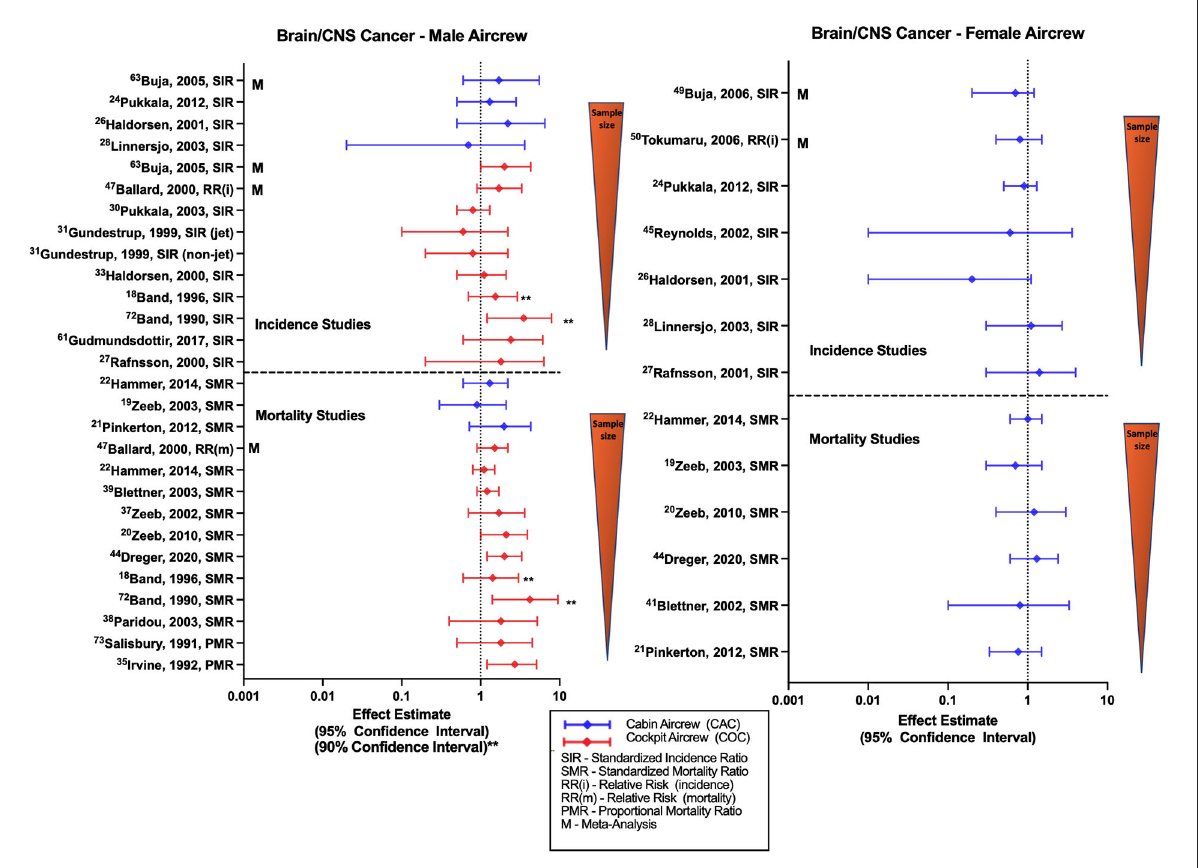
FIGURE8 Forest plot for studies evaluating brain and CNS cancer incidence or mortality ratios among male (left hand side graph) and female aircrew (right hand side graph) in association to CIR